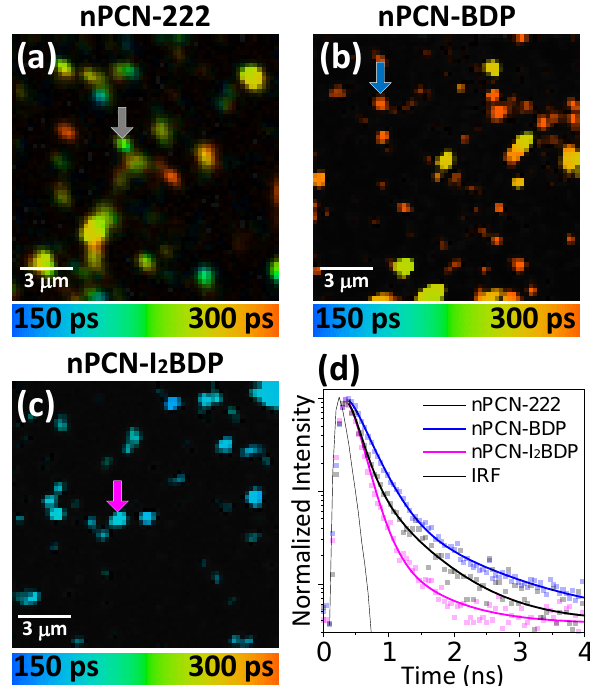
Figure 7. ( a ) Fluorescence lifetime map of pristine nPCN-222 emission (630–750 nm) (same sample with Figure 5a. ( b ) Fluorescence lifetime map of acceptor emission of nPCN-BDP. ( c ) Fluorescence lifetime map of acceptor emission for nPCN-I 2 BDP. The spatial position of ( b , c ) is same with Figure 6a,c, respectively. ( d ) Representative fluorescence lifetime decay curves of acceptor emission obtained at the locations indicated by arrows in ( a – c ) that represent pristine nPCN-222 (Black), acceptor emission for nPCN-BDP (blue) and for nPCN-I 2 BDP (magenta).